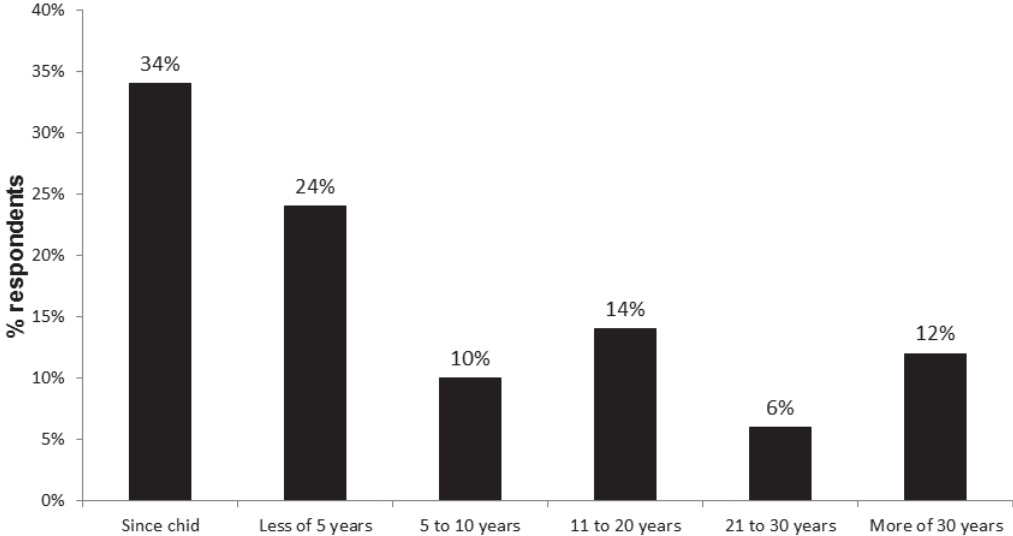
Figure 4 - How long breeders have kept birds as